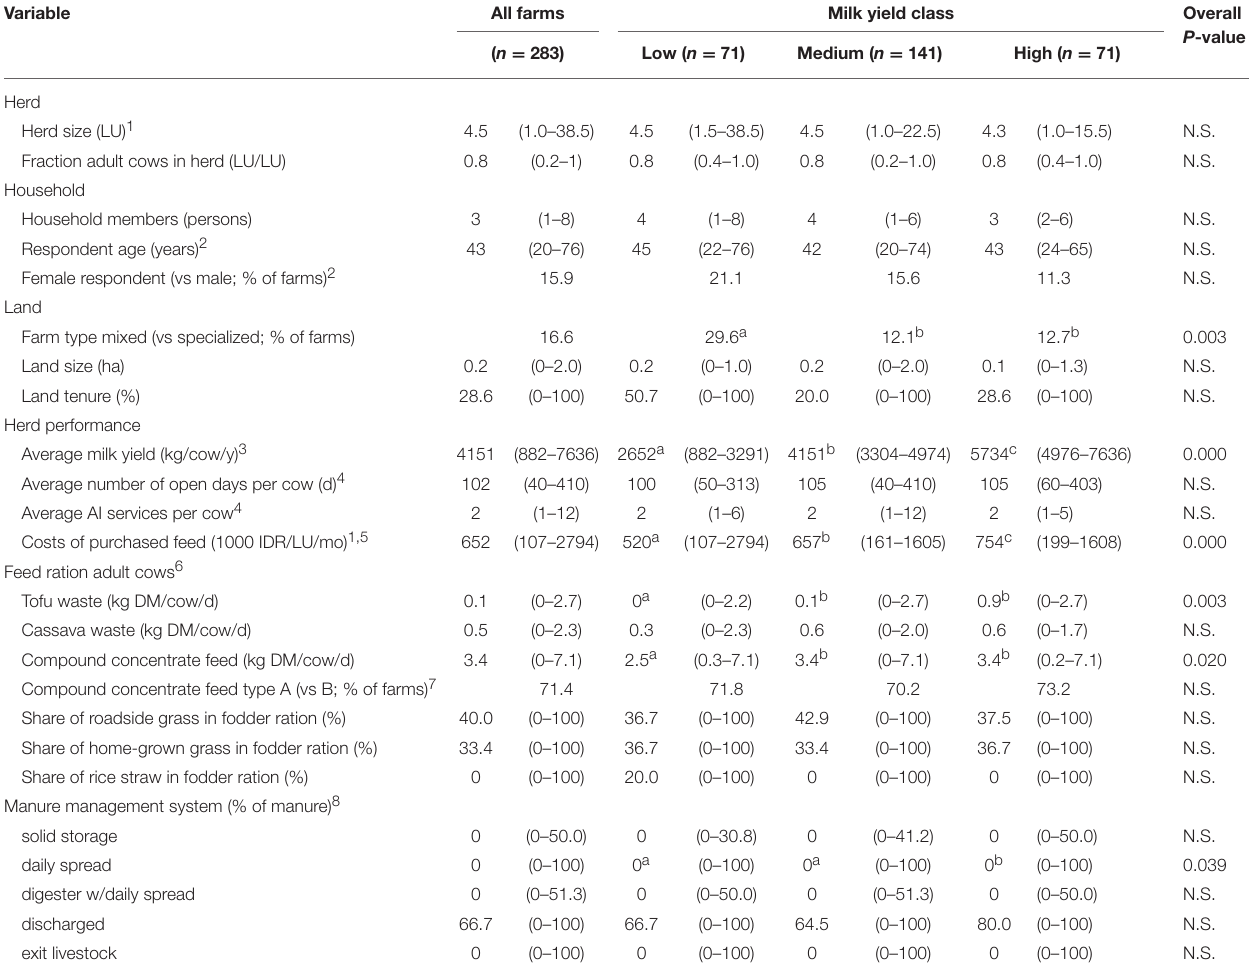
TABLE 3 | Characteristics (median (range), or frequencies) of surveyed dairy farms, and differences between farms with the 25% lowest (“low”), medium 50% (“med”), and 25% highest (“high”) milk yields.